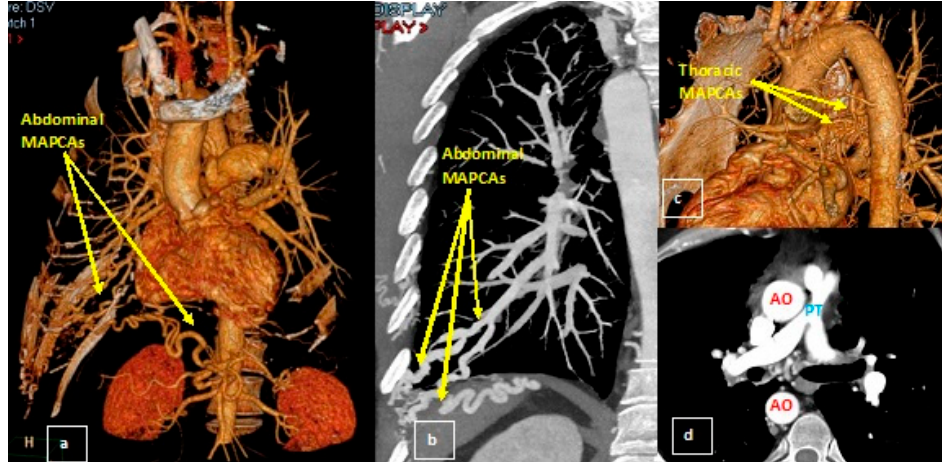
Figure 4. Pulmonary CTA: ( a ) 3D reconstruction and ( b ) MIP reconstruction: abdominal aortopul- monary collateral vessels; ( c ) 3D reconstruction: thoracic aortopulmonary collateral vessels; ( d ) axial